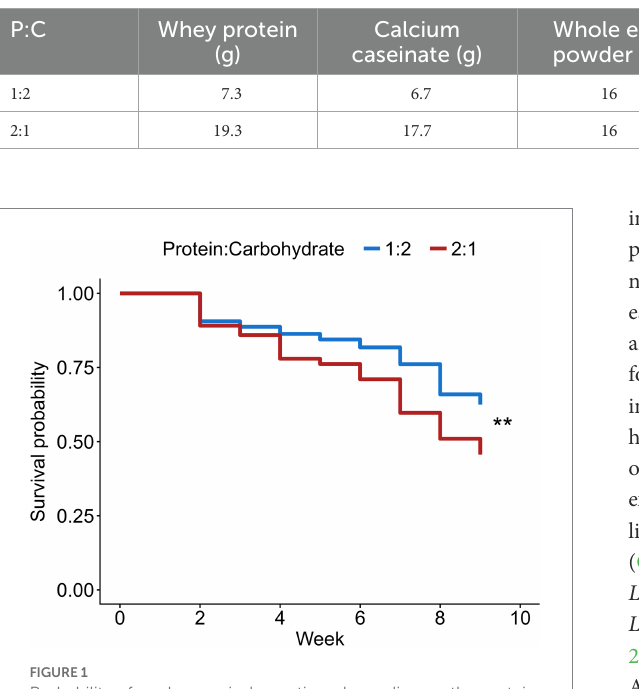
FIGURE 1 Probability of worker survival over time depending on the protein to carbohydrate ratio in the diet. The level of significance is ** p <